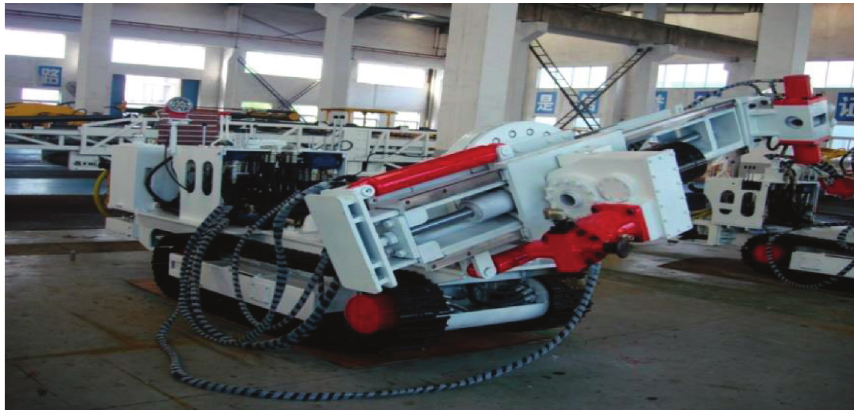
Figure 10: GMS1-6000/55 hydraulic drill for coal mine.